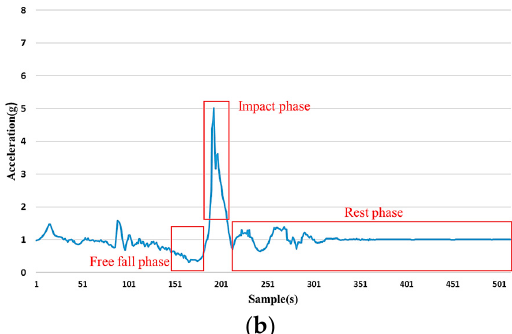
Figure 4. The illustration of the multiphase fall segmentation for two situations. There are three phases, in turn: free fall phase, impact phase, and rest phase. ( a ) The situation of the maximum of Norm xyz is larger than 6 g , taking the data frame of the standing forward fall, for example; ( b ) The situation of the maximum of Norm xyz is less than 6 g , taking the data frame of the back-walking backward fall for example.